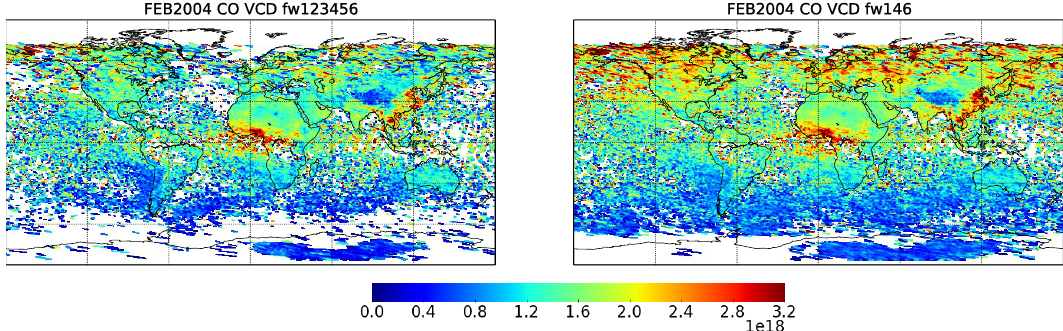
Fig. 6. Comparison of two VCD [ molec / cm 2 ] retrievals for February 2004. Left: all good pixels in the retrieval window are used. Right: pixels over lines with strong water vapour interference are excluded. In the latter case several features like enhanced CO values in South-East Asia and the North-South gradient are more clearly visible.